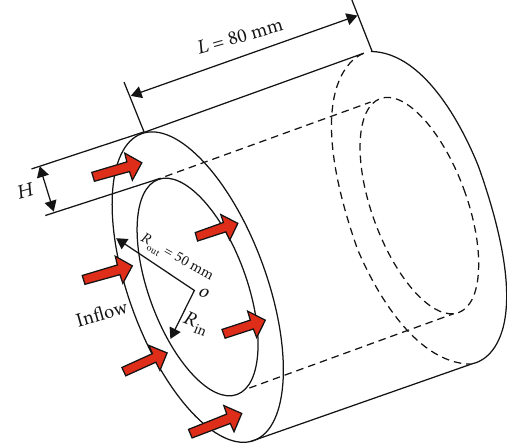
Figure 1: Sketch map of the physical